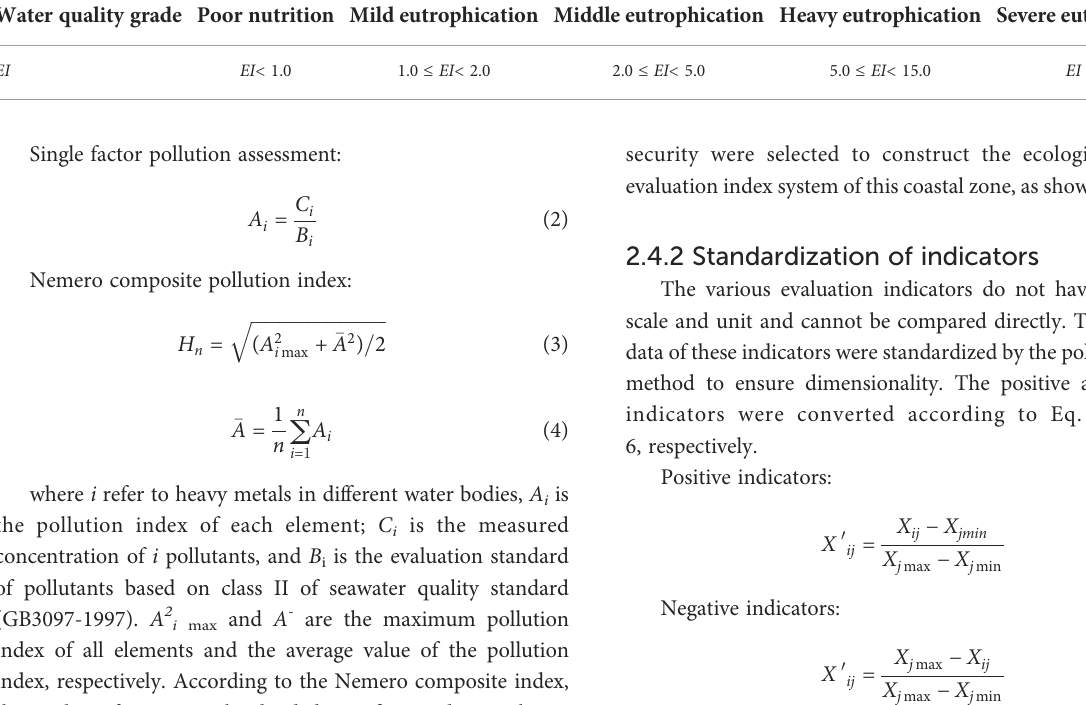
TABLE 1 Standards for classi fi cation of water